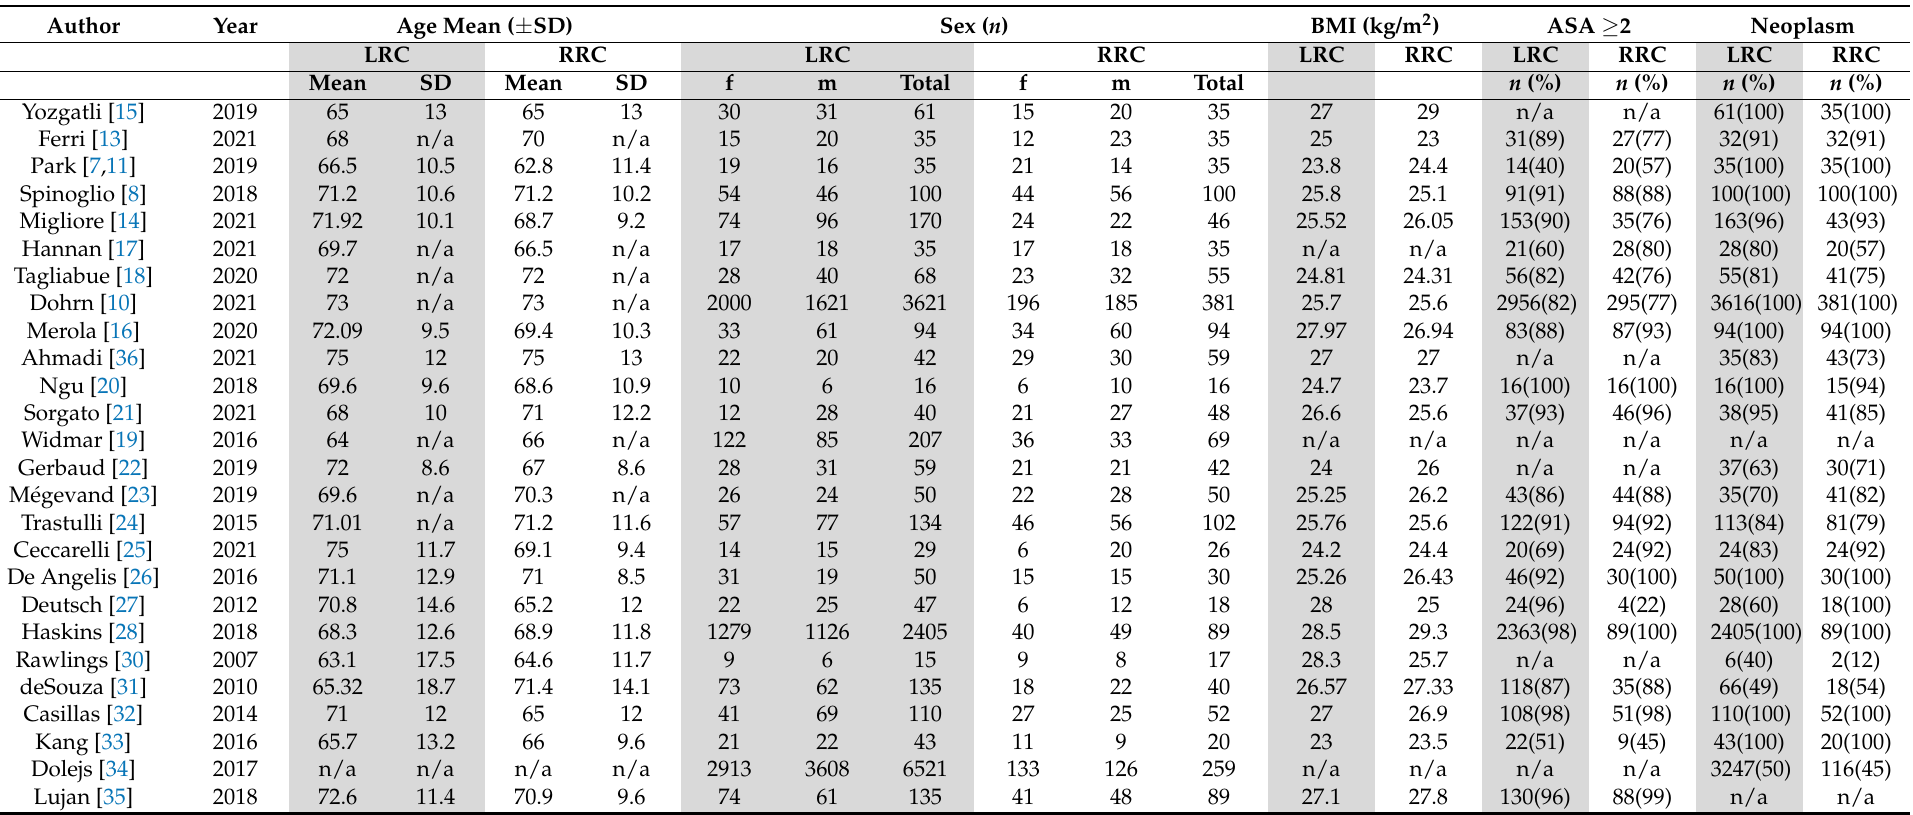
Table 2. Patients’ characteristics in the retrieved